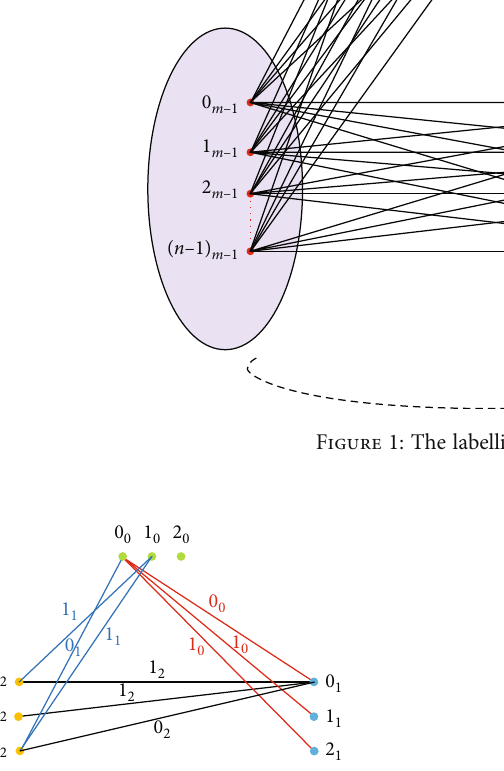
∪ P 0,2 ∪ K 1,2 1,3 4 1,3